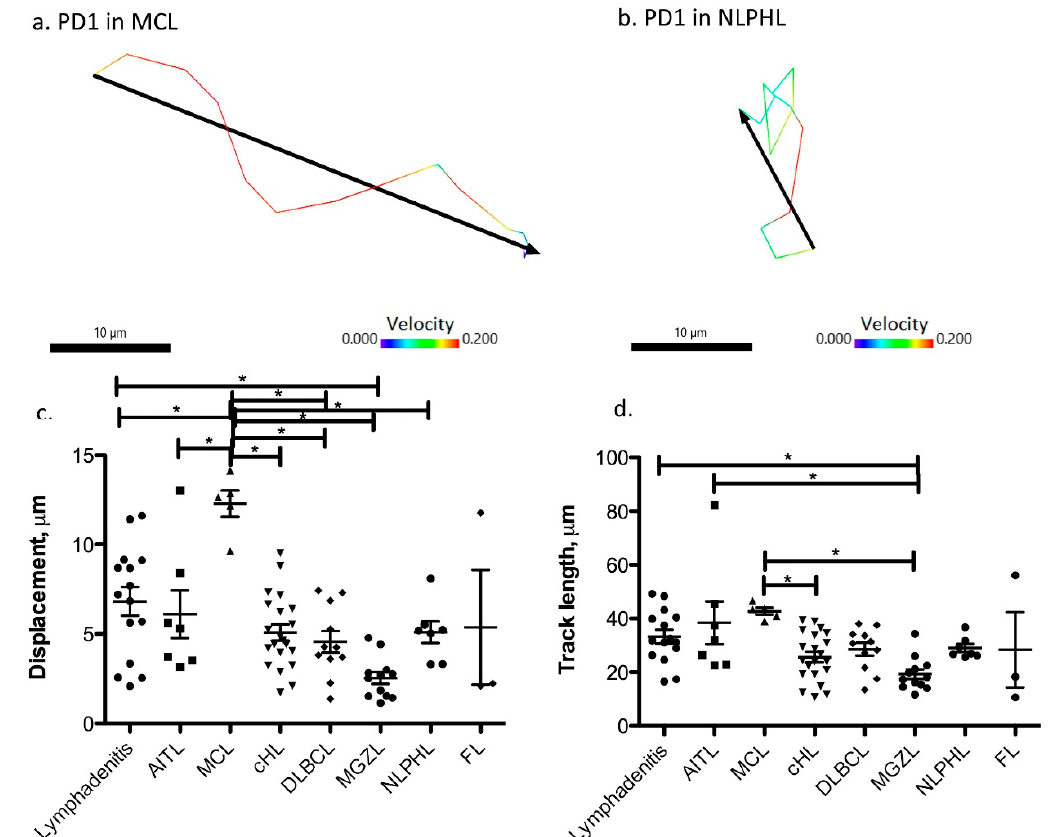
Figure 5. Lymphomas differ in track length and displacement of their PD1-positive T cells. ( a ) Track length (color code according to velocity in µm/s) and absolute displacement (black) of an example of a PD1-positive T cell in mantle cell lymphoma. ( b ) Track length (color code according to velocity in µm/s) and absolute displacement (black) of an example of a PD1-positive T cell in NLPHL. ( c ) Absolute displacement of PD1-positive T cells in different lymphomas (* p < 0.05, one-way ANOVA with Bonferroni’s post-test for multiple comparisons). Each dot represents the mean from one movie. Lymphadenitis: 5 cases, AITL, NLPHL and MCL: one case, MGZL, DLBCL and FL: two cases, cHL: three cases. ( d ) Accumulated track length of PD1-positive T cells in different lymphomas (* p < 0.05, one-way ANOVA with Bonferroni´s post-test for multiple comparisons). Each dot represents the mean from one movie. Lymphadenitis: 5 cases, AITL, NLPHL and MCL: one case, MGZL, DLBCL and FL: two cases, cHL: three cases.